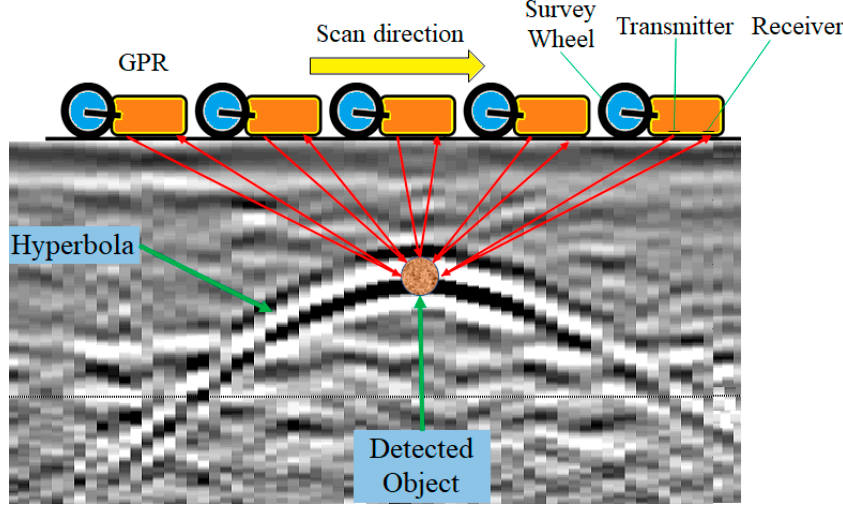
Figure 2. A GPR generates a hyperbola when an object is detected.